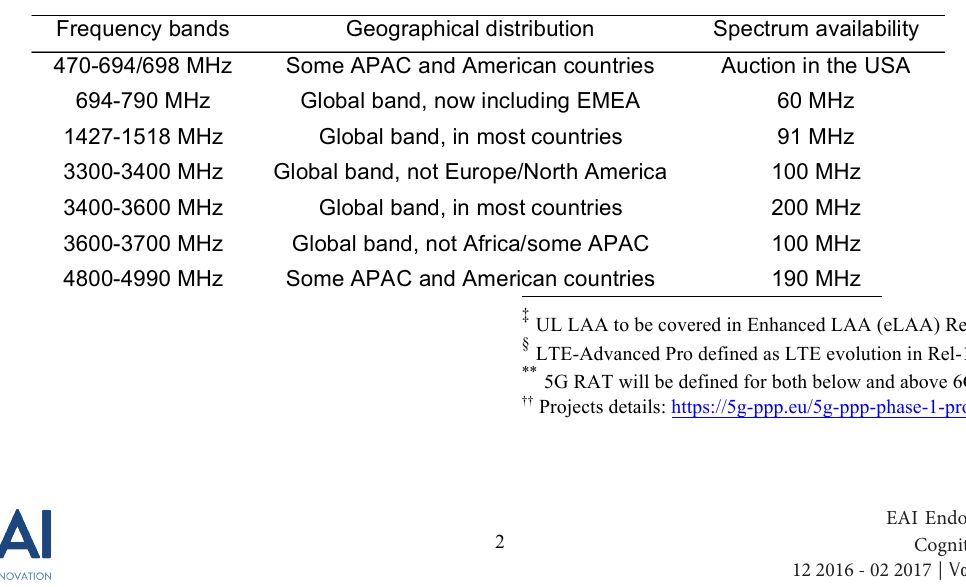
Table 1. WRC-15 decisions on spectrum allocation for 4G mobile services